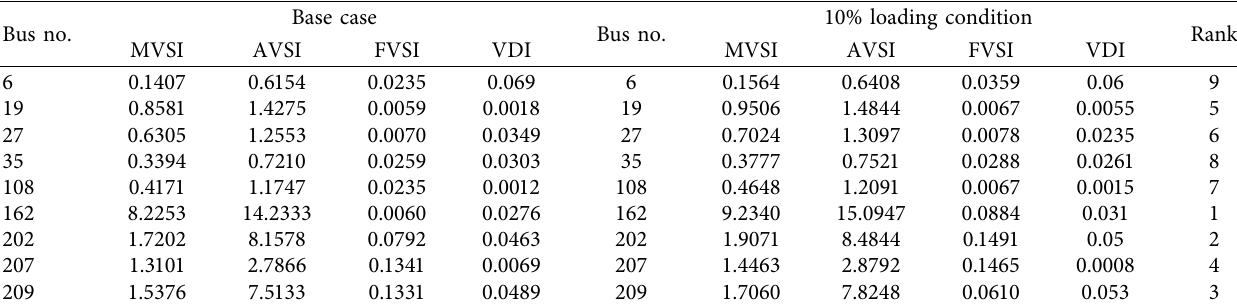
Table 2: Values of stability indices at base case and 10% load increasing conditions. Bus